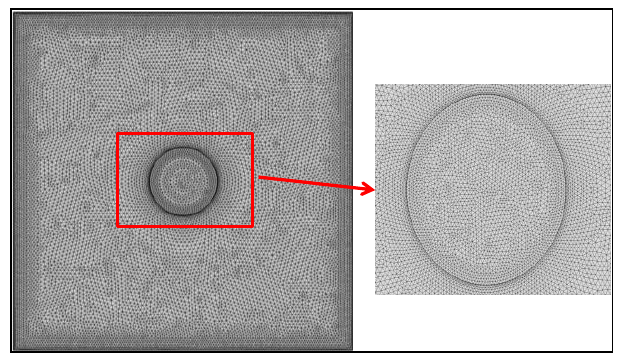
Fig. 2. Typical grid used for simulation.